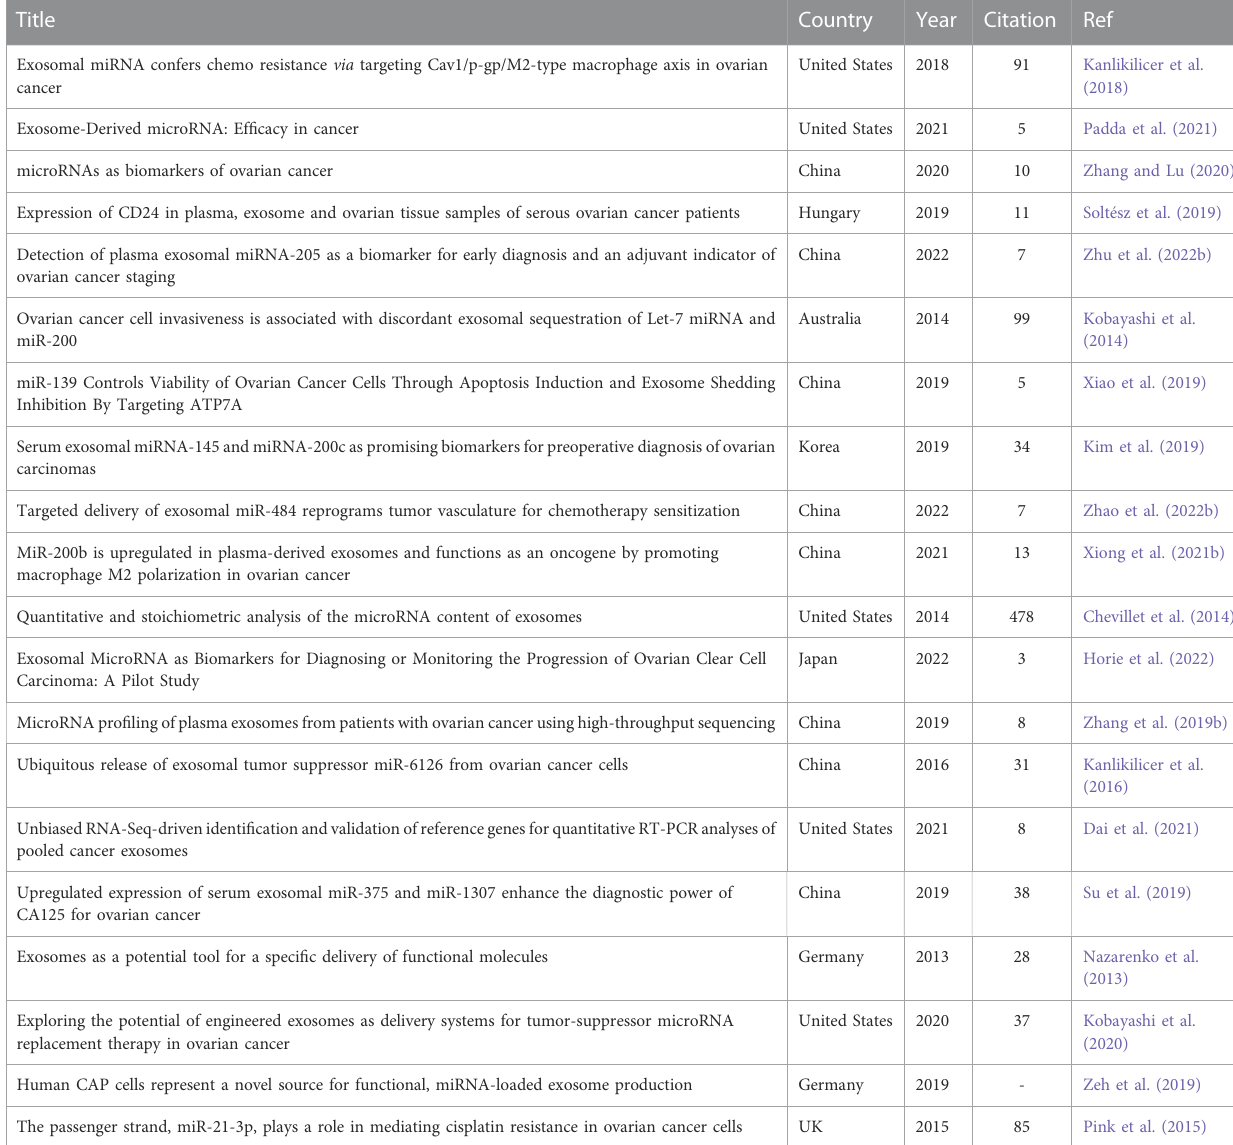
TABLE 6 List of articles in the fi led of miRNA, exosome and ovarian cancer.